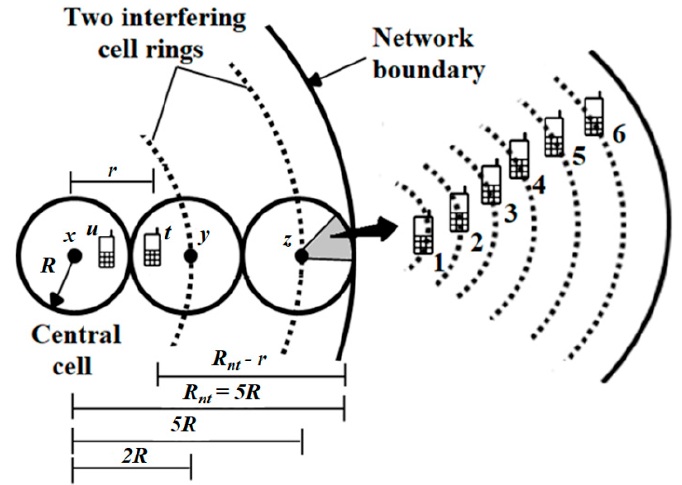
Figure 1. Fluid model for uniformly distributed cells. Zoomed view shows a uniform UE distribution in each cell.